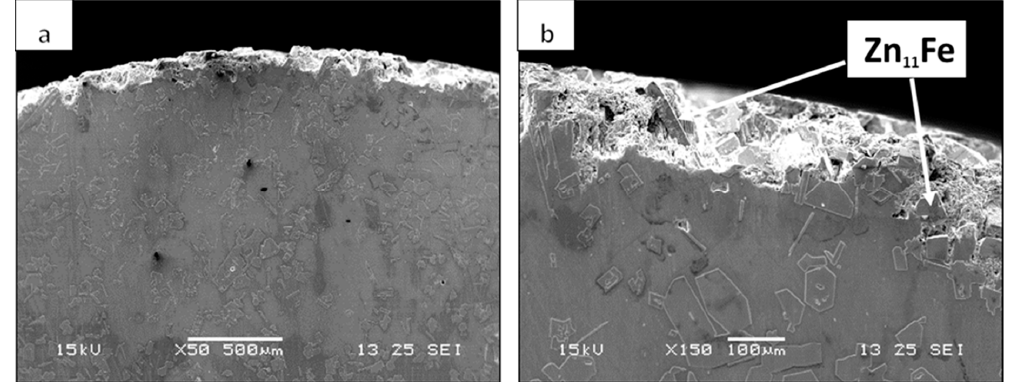
Figure 6. Surface cross section showing corrosion attack of Zn–1.3Fe alloy after 10 days of exposure: ( a ) Macro view. ( b ) Close-up view.